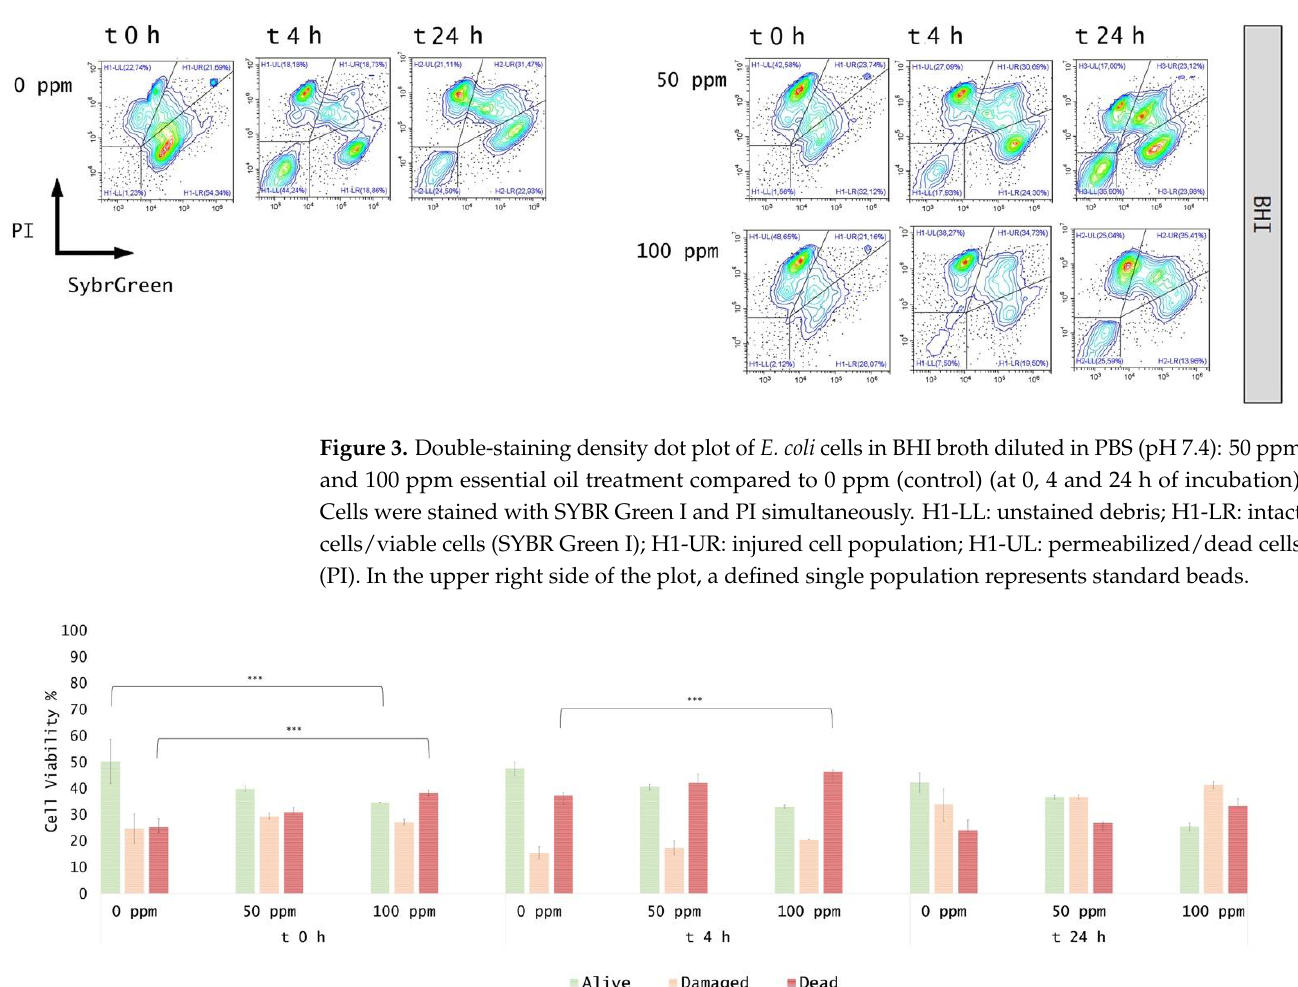
Figure 2. E. coli cell load in Brain Heart Infusion medium and plated on MacConkey agar (Log CFU/mL): OEO (0, 50, and 100 ppm).